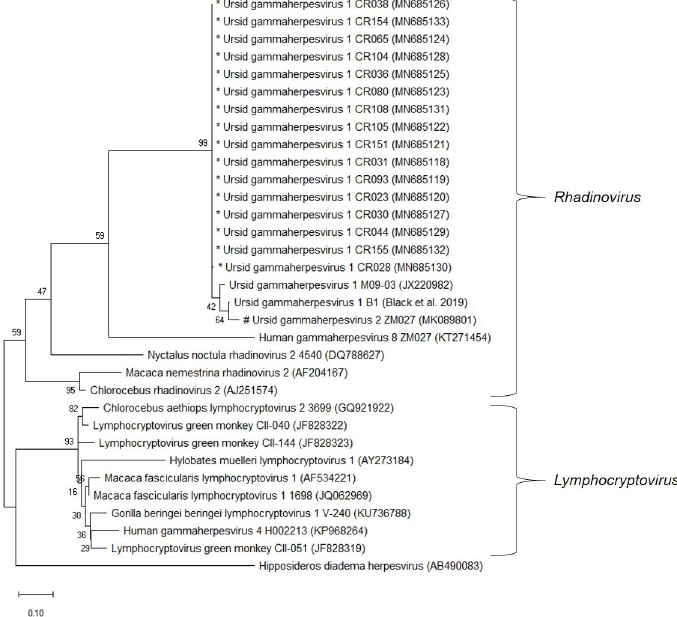
Fig 3. The evolutionary relationship of Ursid gammaherpesvirus 1 strains compared to representative gammaherpesviruses based on partial DNA polymerase (pol) gene sequences. The tree was built using the Maximum Likelihood method based on the Tamura 3-parameter model to compute the evolutionary distances. The percentage of replicate trees in which the associated taxa clustered together in the bootstrap test (500 replicates) are shown next to the branches. Evolutionary analyses were conducted in MEGA X (version 10.1.1). � sequences were generated in this study. # As designated by Troyer et al (GeneBank accession: MK089801). However, further sequence data is needed to confirm the designation of a distinct viral